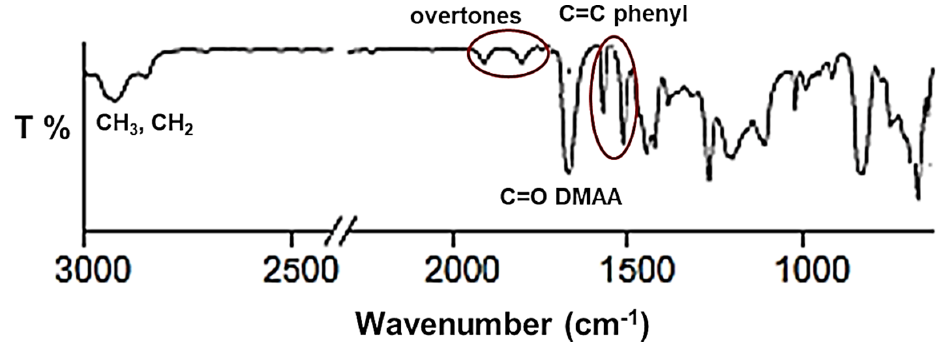
Figure 1. Significant part of FTIR spectrum of P7.